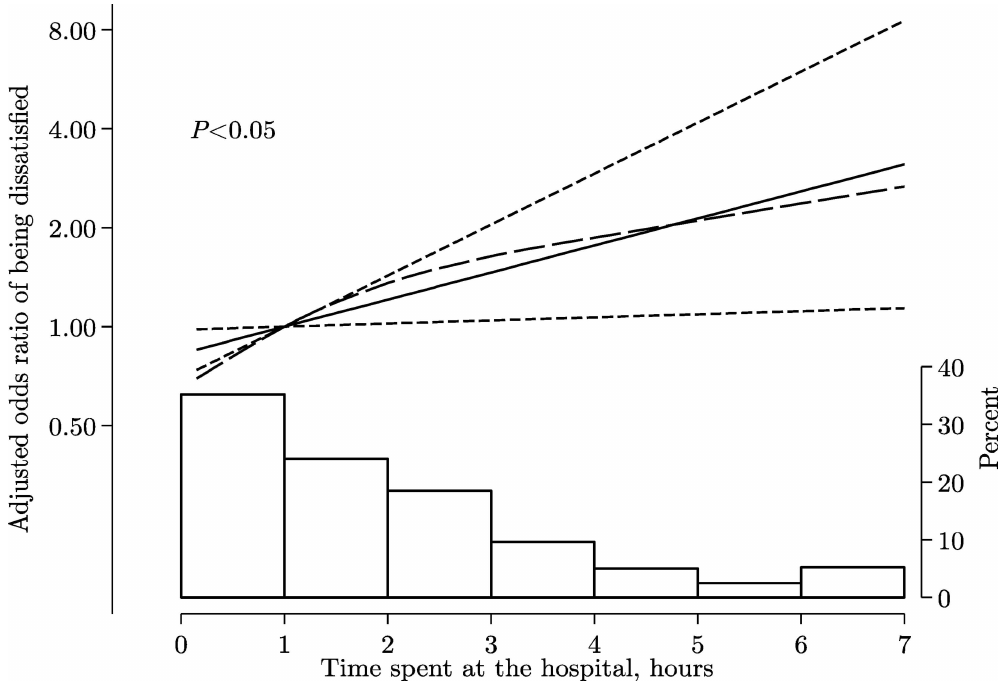
Fig 2. Odds ratio of being dissatisfied with the PMTCT servicesaccording to time spent at the hospital (hours). Data were fitted using a multiple logistic regression model adjustingfor patients perceivedpoor health care workers’ communication skills and understanding of patients concerns. Solid line is a linear trend, dashed lines are 95% confidencelimits of the linear trend, and the long-dashline is the curvilineartrend estimated with restricted cubic